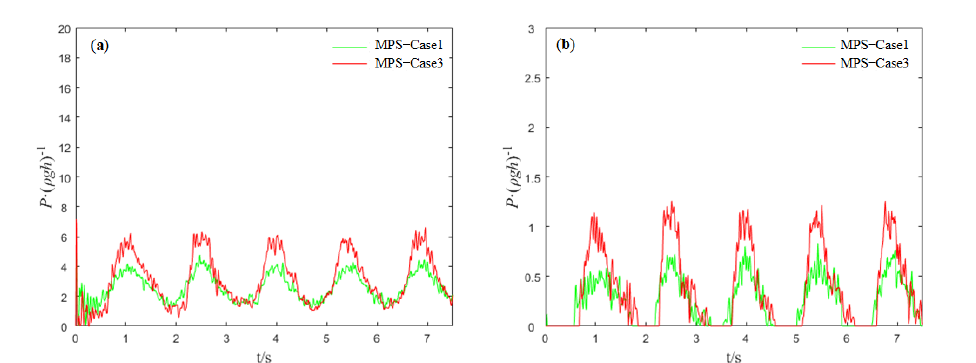
Figure 11. Comparison of dynamic pressure at different rolling angles in case 1 and case 3 at two probes. ( a ) P 1 ; ( b ) P 2 .